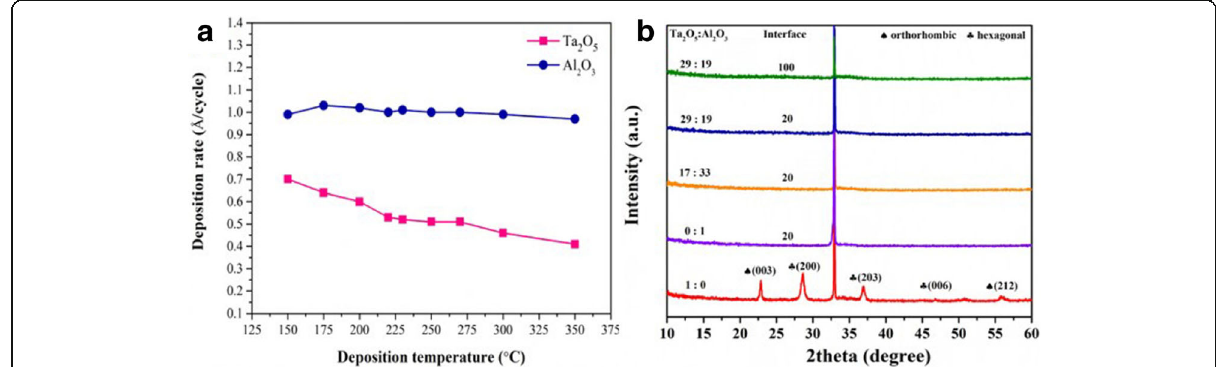
Fig. 1 a The deposition rate of Ta 2 O 5 and Al 2 O 5 as a function of deposition temperatures. b The XRD patterns of Ta 2 O 5 , Al 2 O 3 , and Ta 2 O 5 -Al 2 O 3 composite films annealed at 700